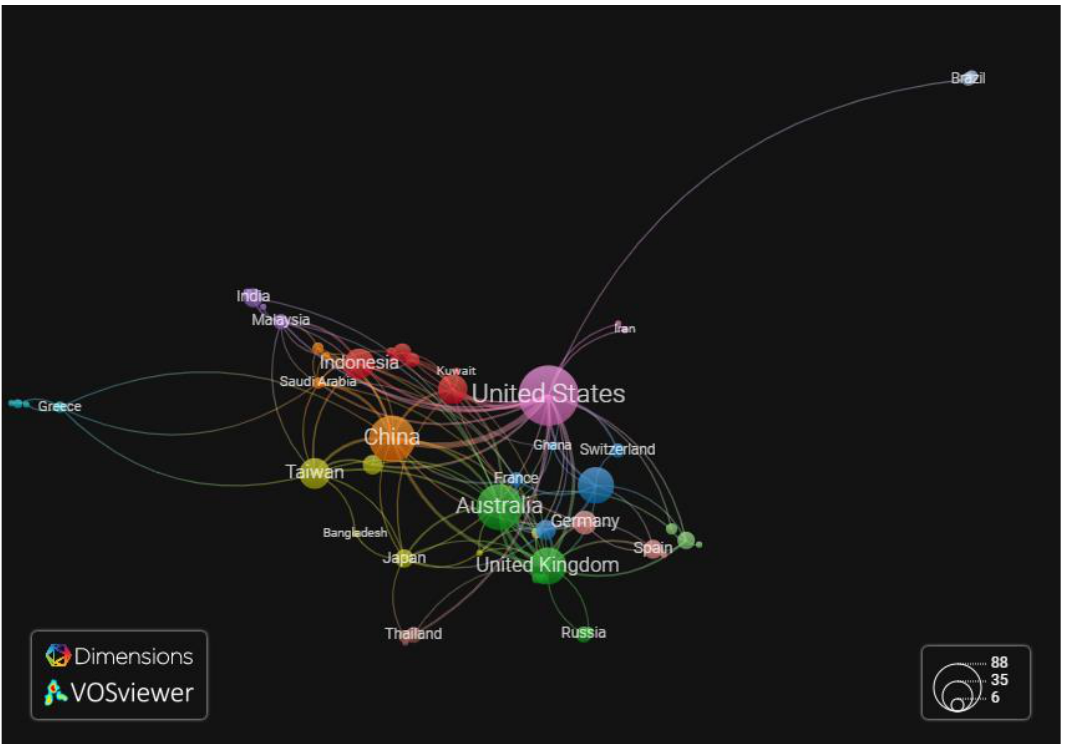
Figure 8 . Countries interaction and distribution .